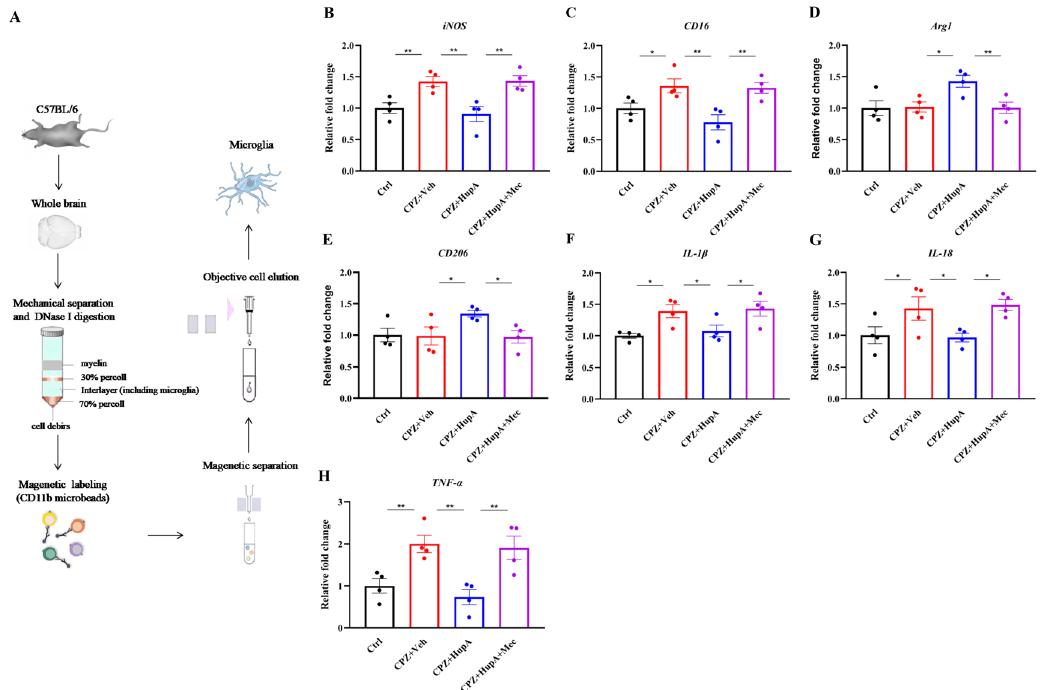
Figure 7. HupA modulated the expression of pro-inflammatory and anti-inflammatory molecules in the microglia. ( A ) Administration of microglia extraction by magnetic beads. ( B – E ) The result of qRT-PCR was to assess the mRNA expression of pro-inflammatory genes ( iNOS and CD16 ) and anti-inflammatory genes ( Arg1 and CD206 ) in the microglia. ( F – H ) The result of qRT-PCR analysis to detect the expression of pro-inflammatory cytokines ( IL- 1β , IL-18 , and TNF- α ) in the microglia. The results represent the mean ± SEM (* p < 0.05, ** p < 0.01, n = 4 mice per group).